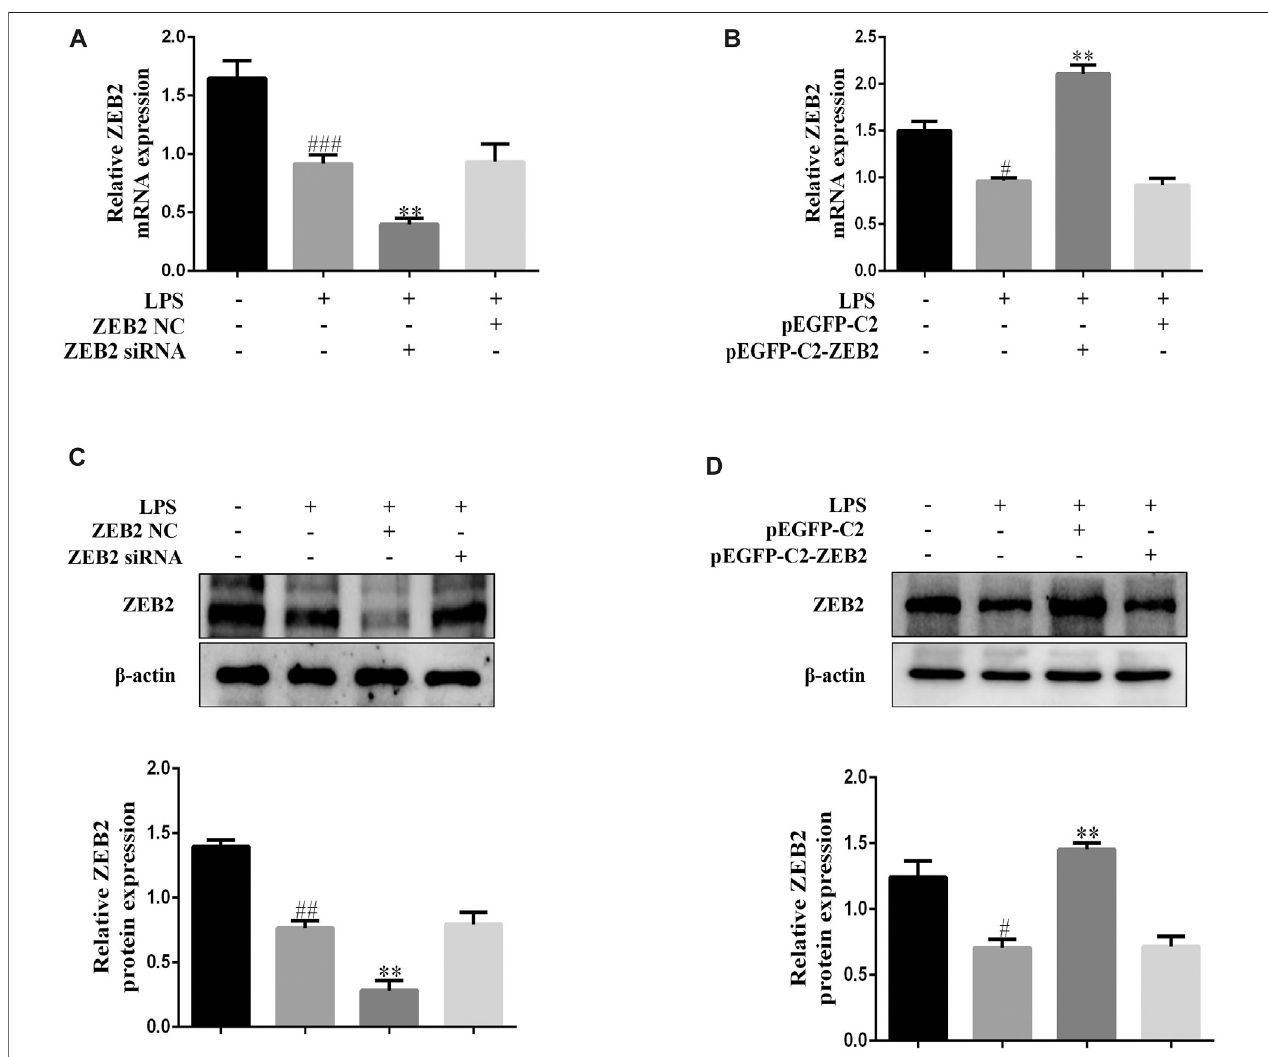
FIGURE 4 | Lipidosome-mediated transduction leading to overexpression or knockdown of ZEB2 in L-02 cells. (A) and (B) : The mRNA expression levels of ZEB2 were measured using qRT-PCR in LPS-induced L-02 cells transfected with ZEB2 siRNA and pEGFP-C2-ZEB2 (C) and (D) : The protein expression levels of ZEB2 were measured using WB analyses in LPS-induced L-02 cells transfected with ZEB2 siRNA and pEGFP-C2-ZEB2. The assays were performed at least three times, with similar results. Data are shown as the means ± SD ( n (cid:2) 3) of one representative experiment; ###p < 0.001 and ##p < 0.01, #p < 0.05 versus normal groups; **p < 0.01 and *p < 0.05 versus the LPS